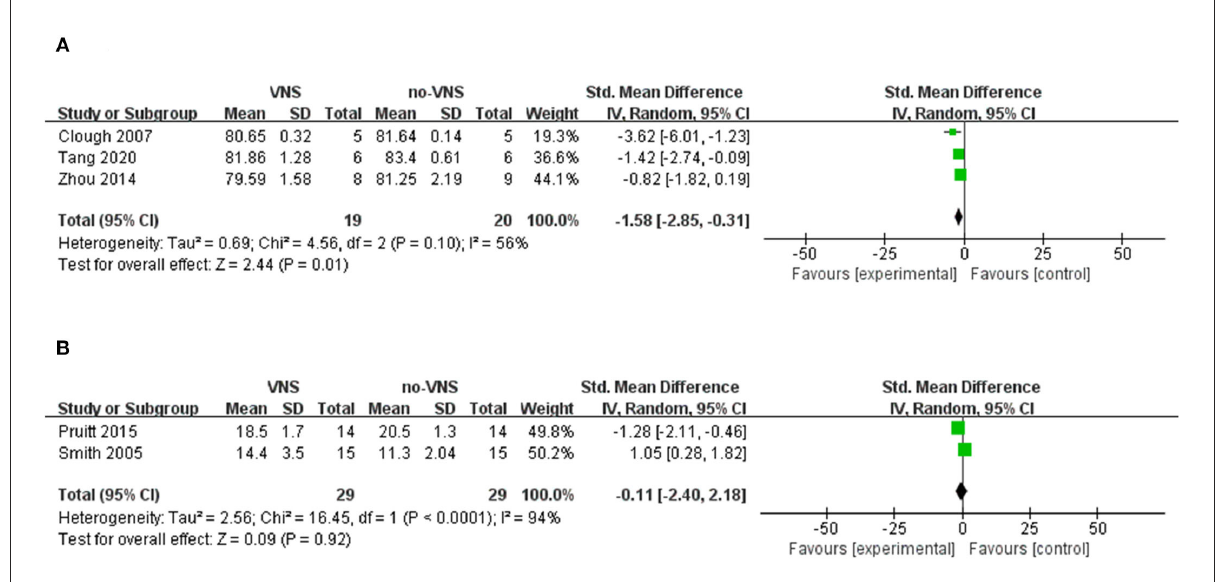
FIGURE2 Forest plot for comparison: VNS vs. no-VNS. Brain water content (A) , lesion size (B) .